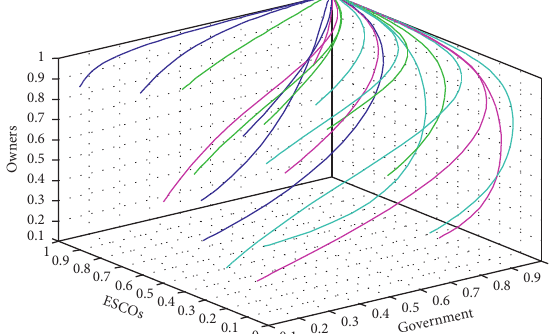
Figure 9: Government-ESCOs-owners.